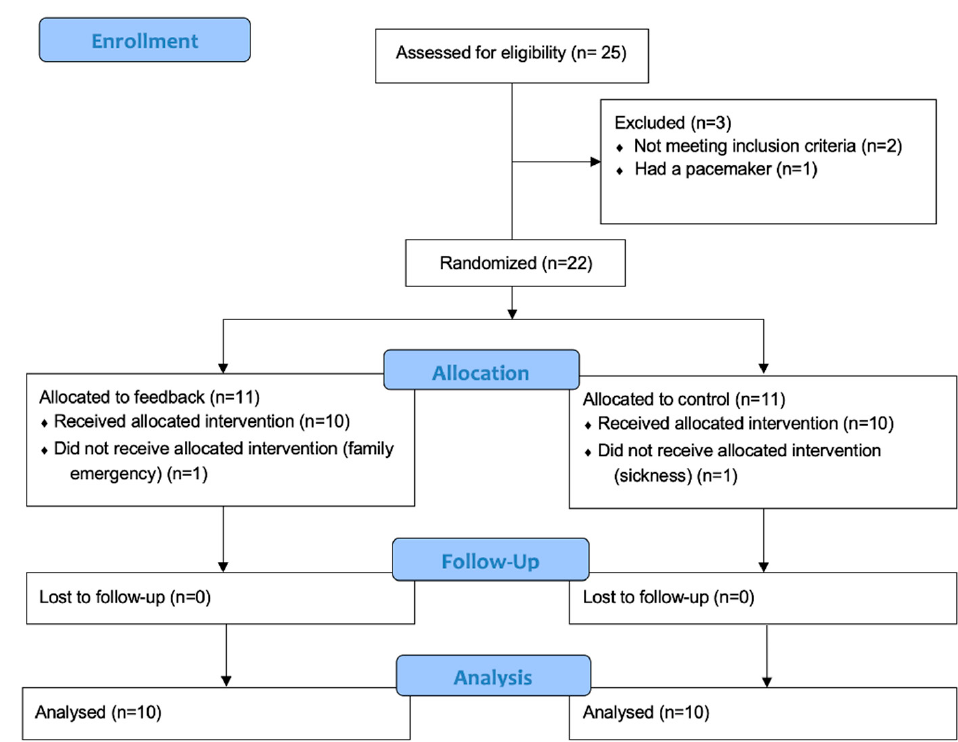
Figure 4. CONSORT flow diagram.